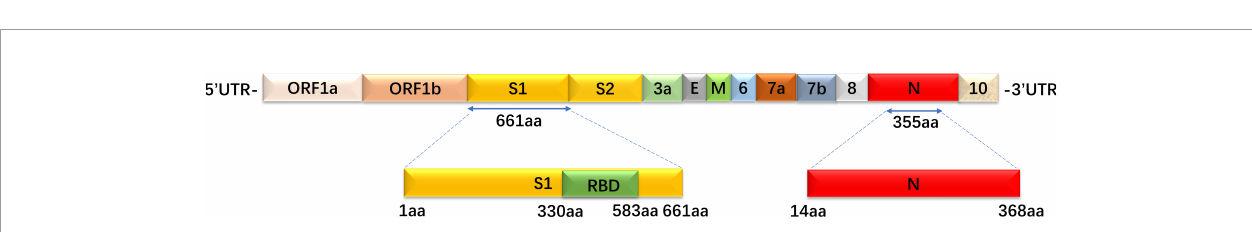
FIGURE 2 | The recombinant S1, RBD, and N protein amino acid position mapping. These three proteins were used as coated target antigens to establish indirect ELISA to detect IgG antibody levels against SARS-CoV-2.